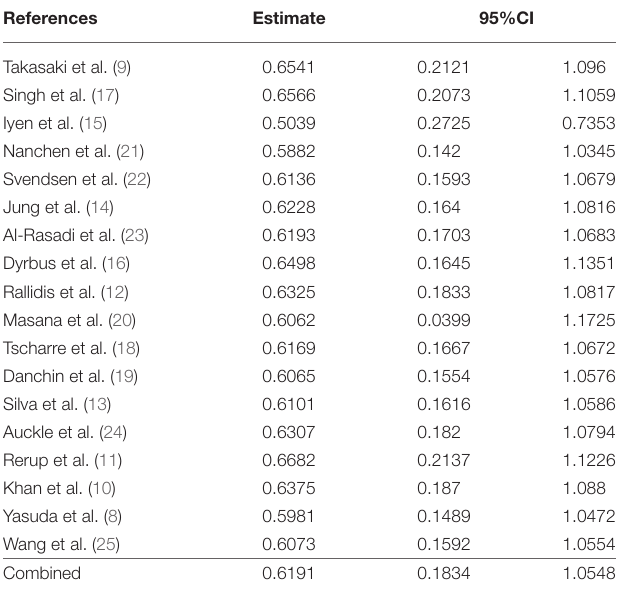
TABLE 3 | Sensitivity analysis of the included studies.